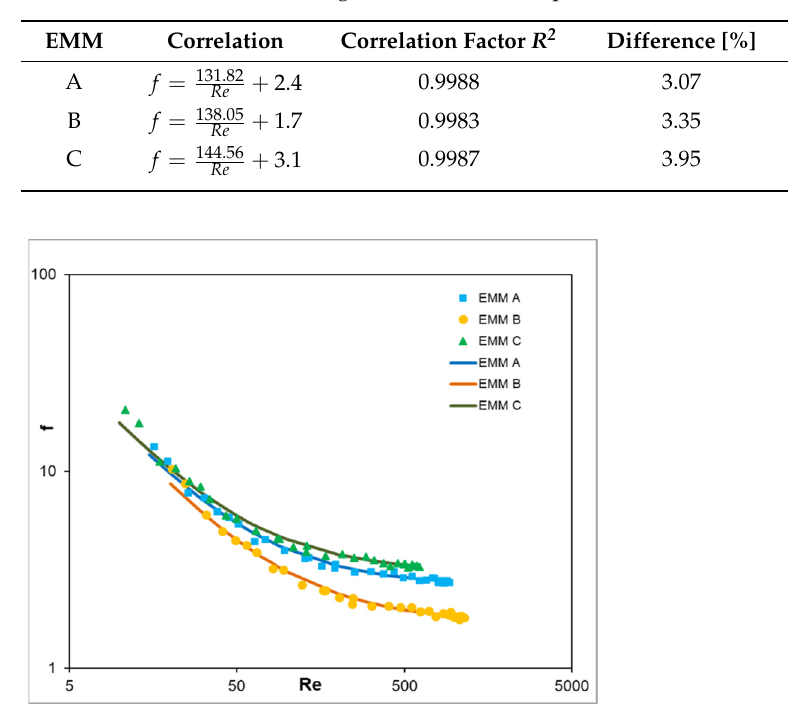
Figure 6. Comparison of Fanning friction factor derived from experiments (points) and calculated by correlations from Table 3 (lines).